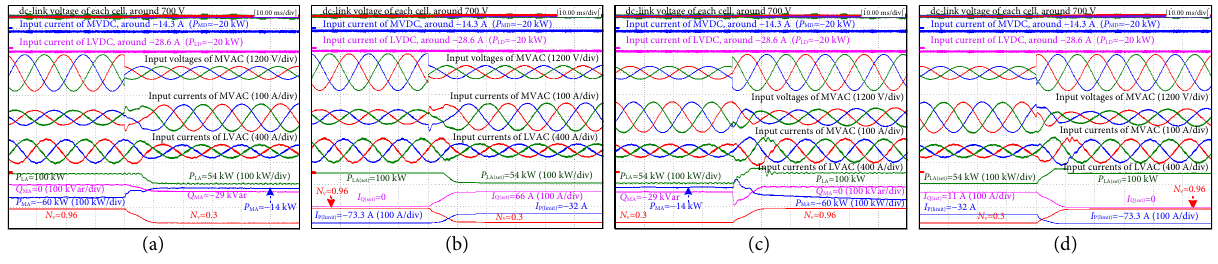
Fig. 20 Experimental results of LVRT Mode-1 in Case-3 of active-power configuration. (a) Real-time power curve in the voltage sag process. (b) Power command curve in the voltage sag process. (c) Real-time power curve in the voltage recovery process. (d) Power command curve in the voltage recovery process. dc-link voltage of each cell, around 700 V Input current of MVDC, around −14.3 A ( P MD ≈−20 kW) Input current of LVDC, around −28.6 A ( P LD ≈−20 kW)